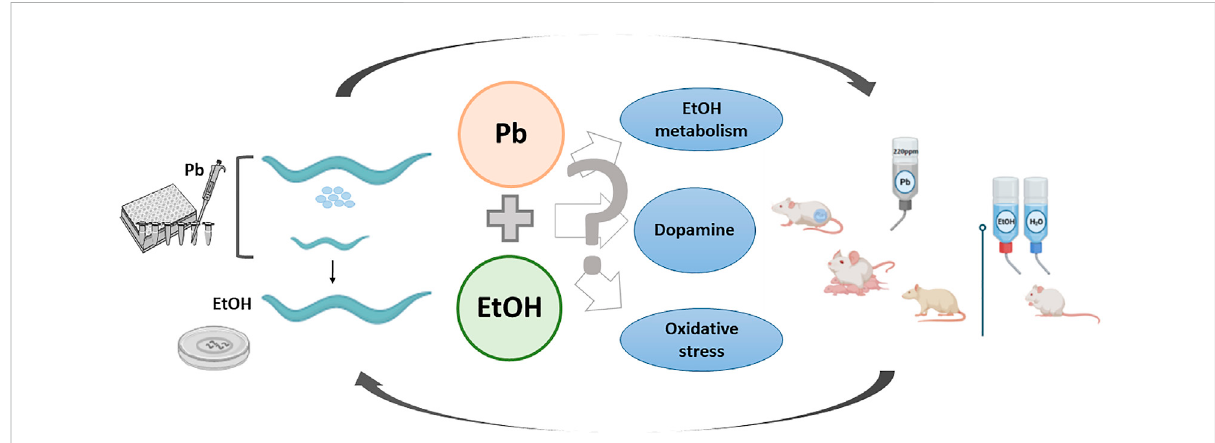
FIGURE 1 Lead and ethanol exposure protocols in two animal models and possible underlying toxic mechanisms resultant of their